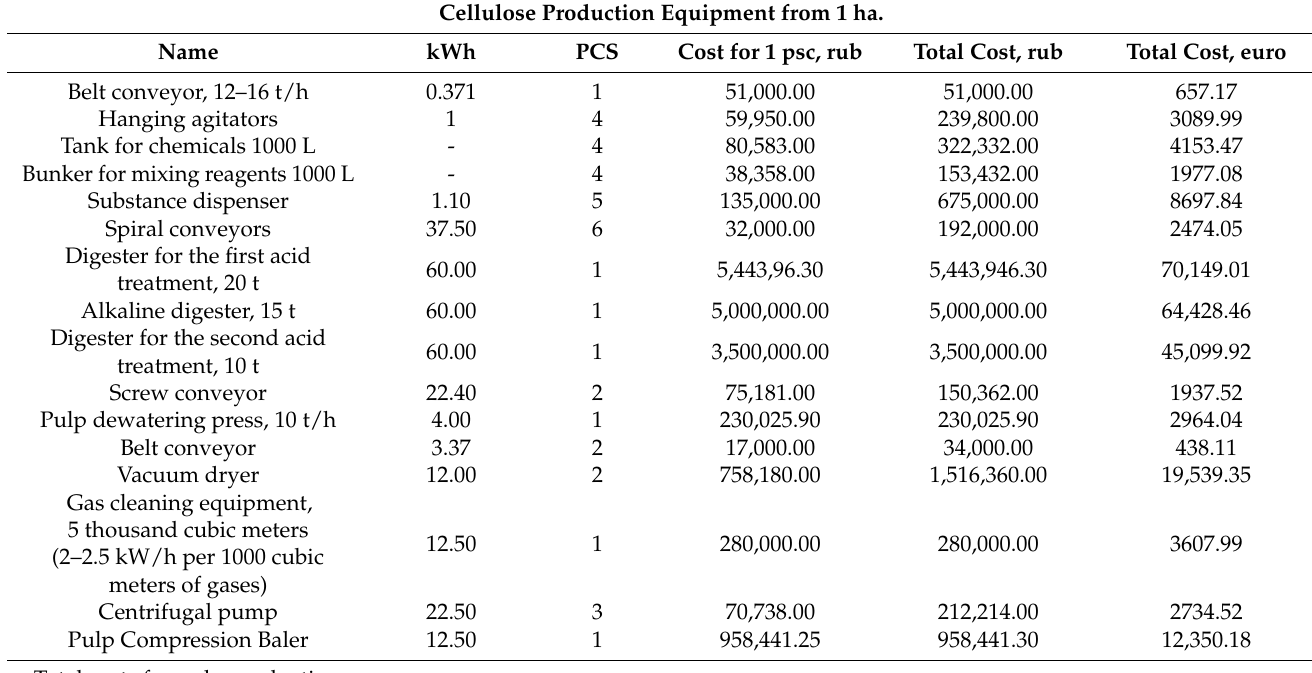
Table 4. Costs for equipment and its operation from one hectare of hogweed field.